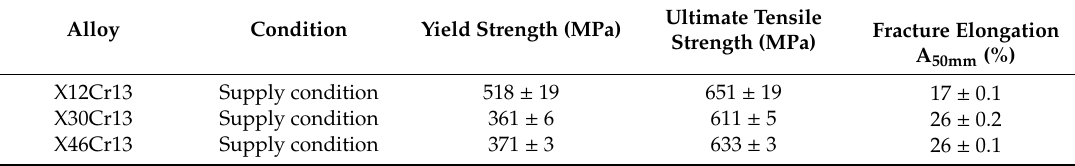
Table 4. Mechanical properties of the investigated alloys in the initial state at room temperature by tensile test with universal testing machine H&P Inspekt